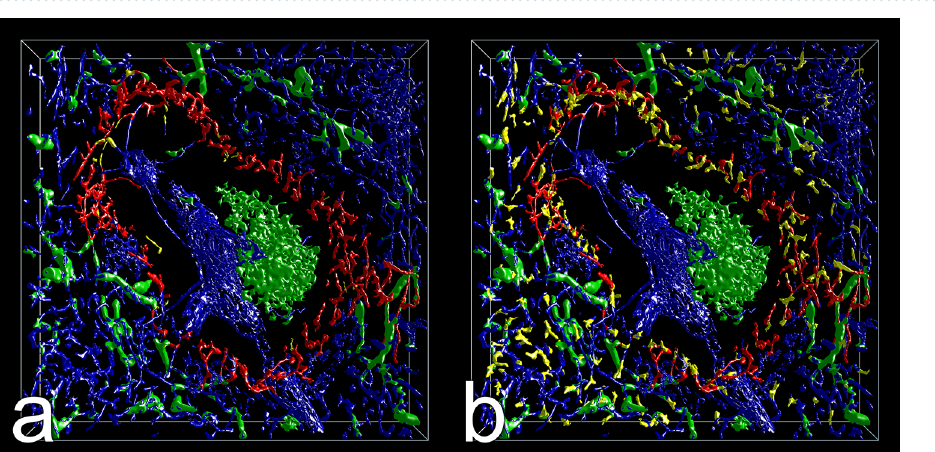
Figure 9. Highlighted perifollicular capillary network in ROI 2 with open ends. ( a ) CD34 single-positive perifollicular capillary endothelium manually highlighted in red with the help of sections. In the corresponding sections (not shown), perifollicular capillaries are CD34 + CD141 − (blue) in contrast to CD34 + CD141 + perifollicular sinuses (brown-black). Artificially interrupted vessels are shown in yellow. ( b ) Perifollicular capillary network (red) with open ends (yellow). Fusion of Figs. 4b and 8a, damaged or ambiguous capillaries not highlighted. Side of bounding box = 1